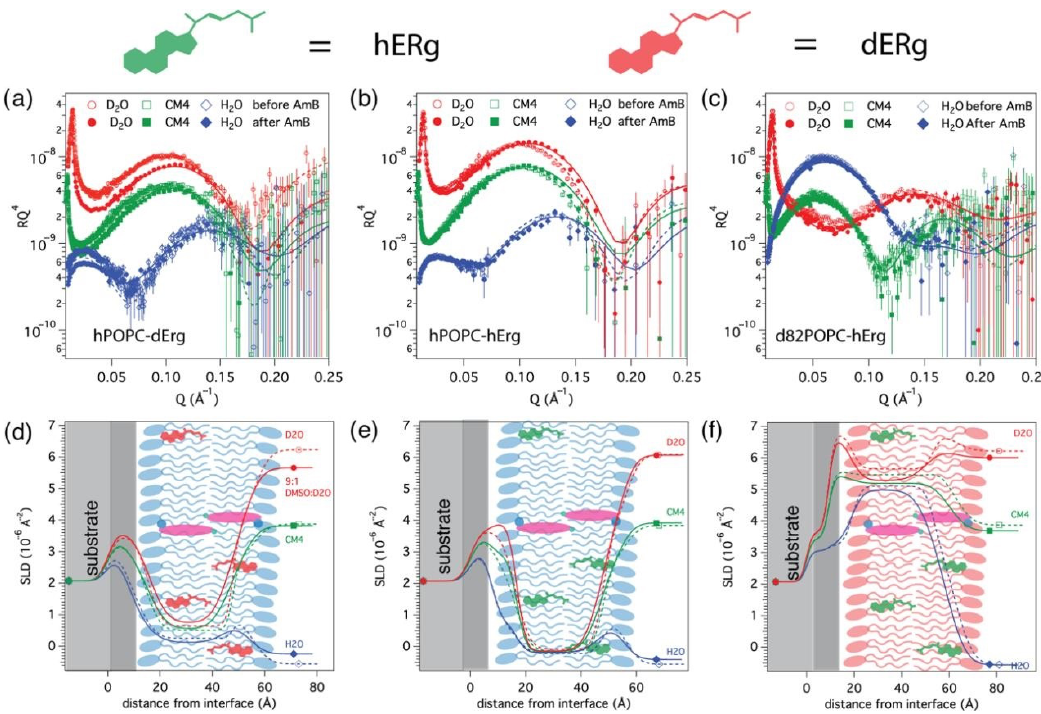
Figure 2. Neutron reflectivity data and the corresponding neutron scattering length density profiles of hPOPC–dErg ( a , d ) and hPOPC–hErg ( b , e ) and d 82 POPC–hErg ( c , f ) bilayers measured in different solvent contrasts at 30 ◦ C before (open symbols / dotted lines) and after (solid symbols / lines) addition of 1 mM AmB. A schematic illustration of the membrane structure and location of ergosterol and AmB corresponding to the fits is presented over the SLD profile ( d – f ). dErg: per-deuterated d 44 ergosterol, hErg: ergosterol. Table 3. Parameters corresponding to the best fits to the data from POPC–ergosterol bilayers before and after AmB addition, as displayed in Figure